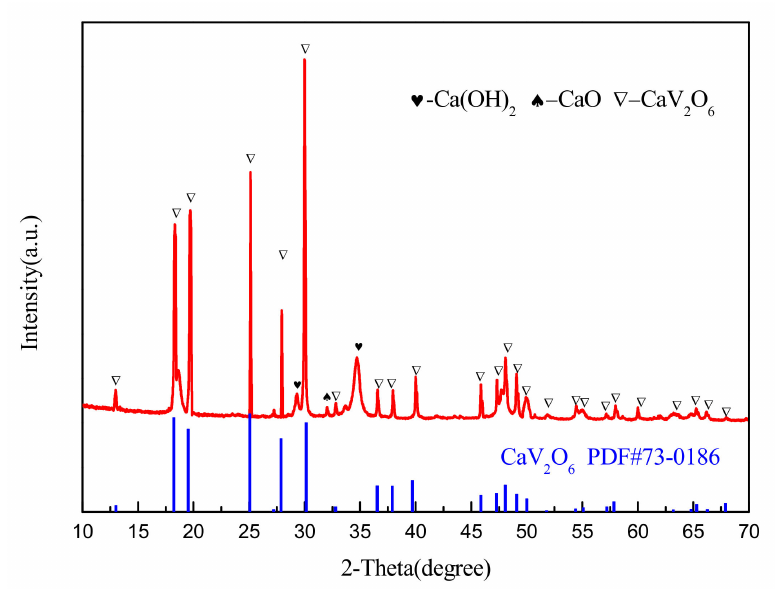
Figure 12. XRD pattern of calcification products.